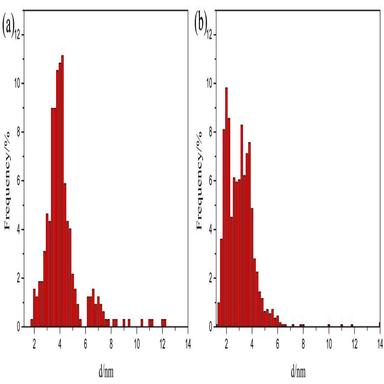
Size distribution of nanoclusters in (a) ODS Eurofer and (b) ODS Eurofer–2V–1.2Ta.